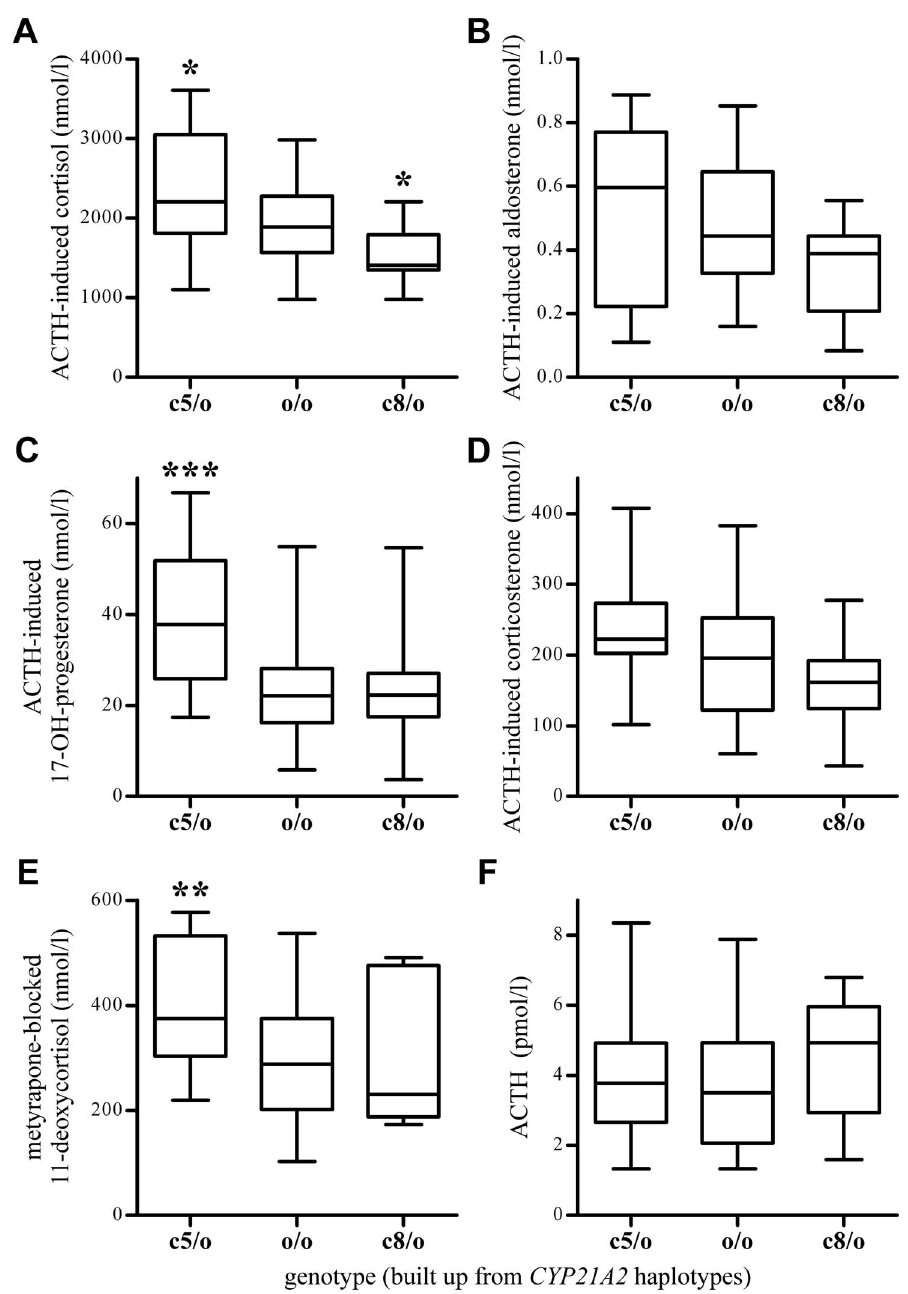
Figure 2. Concentrations of hormones in blood decomposed by CYP21A2 intron 2 haplotype carrier groups in subjects with non- functioning adrenal incidentaloma. c5/o and c8/o indicate the carriers (heterozygotes) of c5 and c8 haplotypes, respectively, and o/o abbreviates the genotypes of other haplotypes. Boxes indicate interquartile ranges, lines in boxes show the medians, whiskers represent the 5 –95 th th percentiles, asterisks above the boxes indicate the significant differences between the hormone levels of genotypes. One, two and three asterisks indicate p , 0.05, p , 0.01 and p , 0.001 respectively (t-test or Mann-Whitney test). A) Serum cortisol level after adrenocorticotropic hormone (ACTH) stimulation. B) Serum aldosterone level after ACTH stimulation. C) Serum 17-OH-progesterone level after ACTH stimulation. D) Serum corticosterone level after ACTH stimulation. E) Serum 11-deoxycortisol level after metyrapone administration. F) Baseline ACTH level.